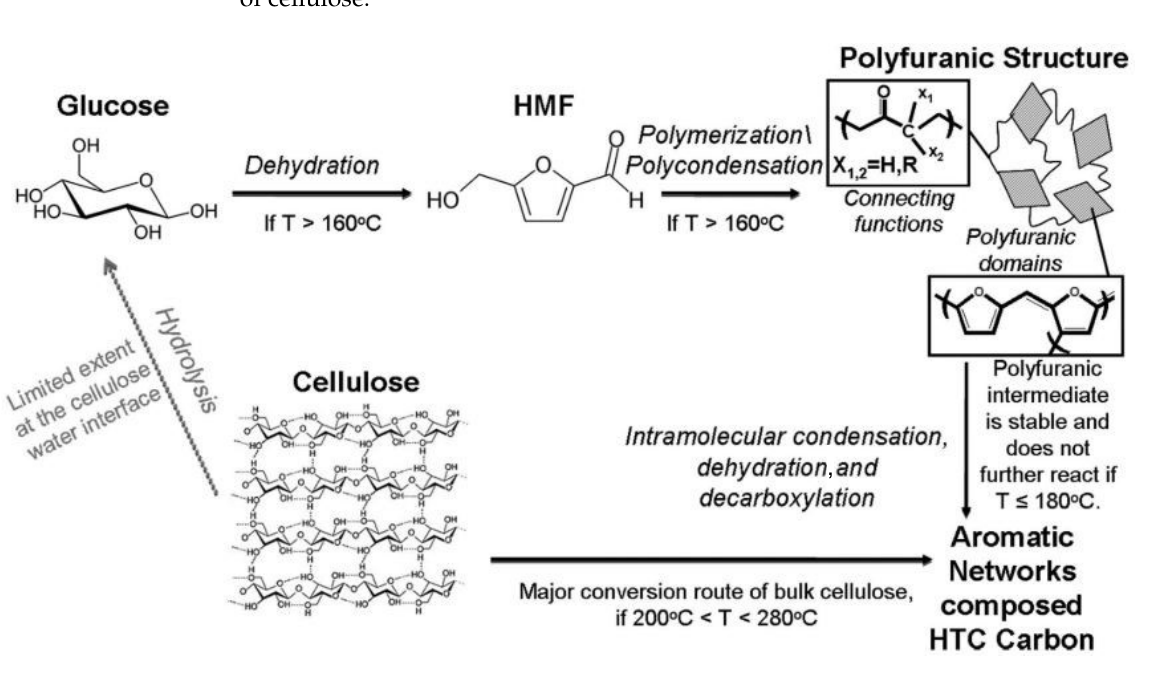
Figure 2. Proposed mechanism for HTC of cellulose. Reproduced with permission from Falco et al. Green Chem. 2011, 13, 3273 published by the Royal Society of Chemistry [64].